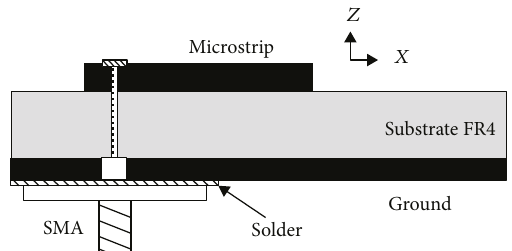
Figure 4: Cross-sectional view of the SMA connector